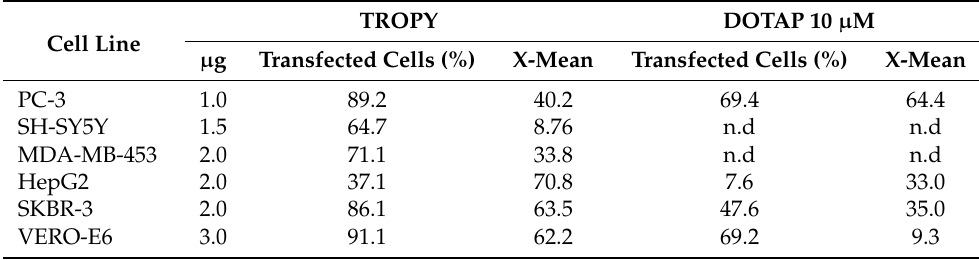
Figure 4. Cell Internalization of PPRHs. ( A ) Images from bright and merge fluorescence microscopy were taken from the three cell lines indicated upon incubation for 24 h with 100 nM FAM-HpScr9 plus 1.5 µg of TROPY. ( B ) Confocal microscopy after incubating PC3 cells with 100 nM FAM-HpScr9 plus 1.5 µg of TROPY. Cells were incubated with WGA 555 to identify cell membranes in red and with Hoechst to label nuclei in blue (upper image). Green complexes of PPRH–TROPY were visualized within the cytoplasm and in the nucleus (lower image). Table 2. Cell lines transfected with TROPY or